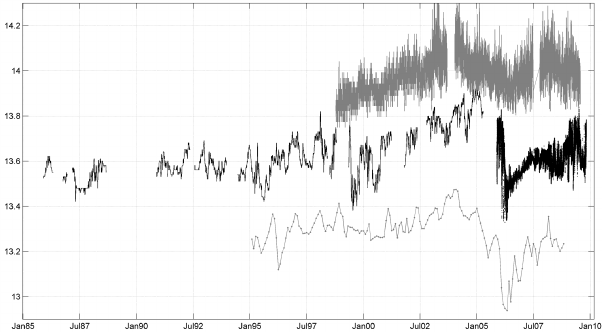
Fig. 16. Comparison between θ time series at 400 m depth at the Sicily Channel (top), the Corsica Channel (middle), and at DY- FAMED (bottom). All values refer to 400m